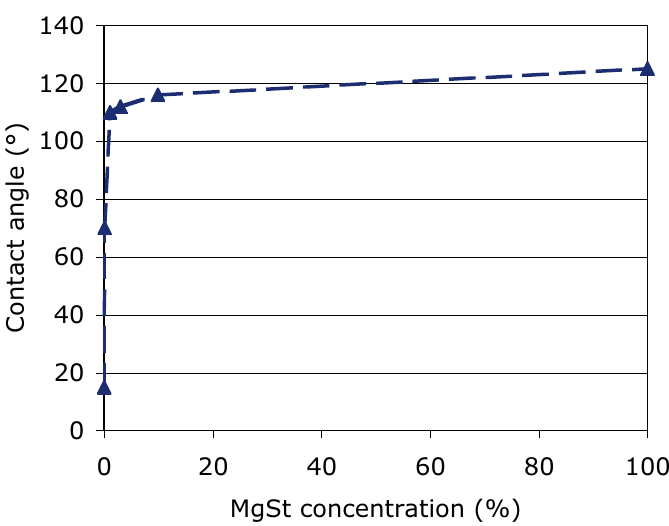
concentration. 2